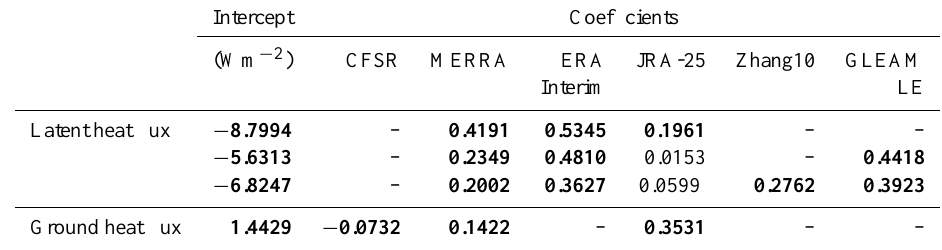
Table 4. Coefficients and intercept to calculate fused data by Eq. (3) (coefficients and intercepts with p value<0.05 are in bold).